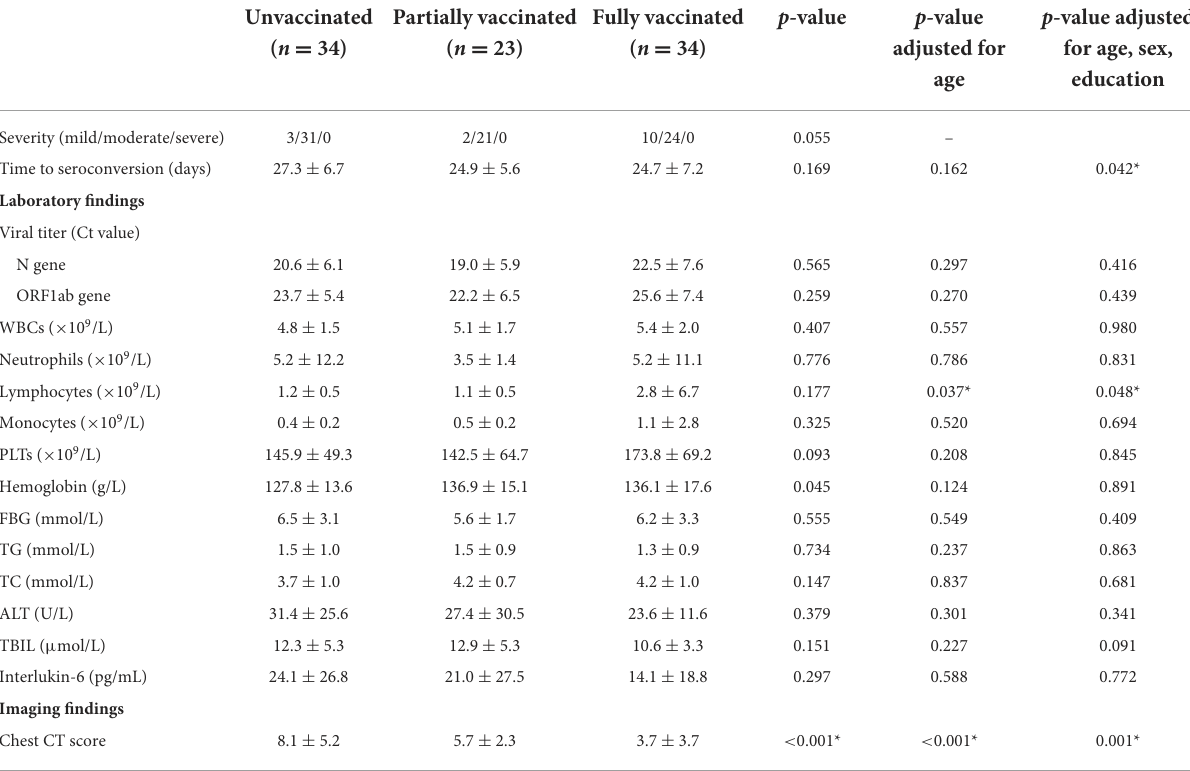
TABLE 2 Hospital course of COVID-19 patients with different vaccination does. Unvaccinated ( n =